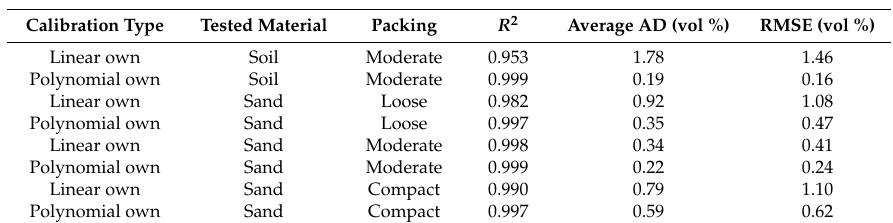
Table 5. Performance comparison of factory (displayed in Table 3) and our own calibrations for direct regression approach of ThetaProbe: R 2 values, averaged AD (vol %), and RMSE values (vol %).